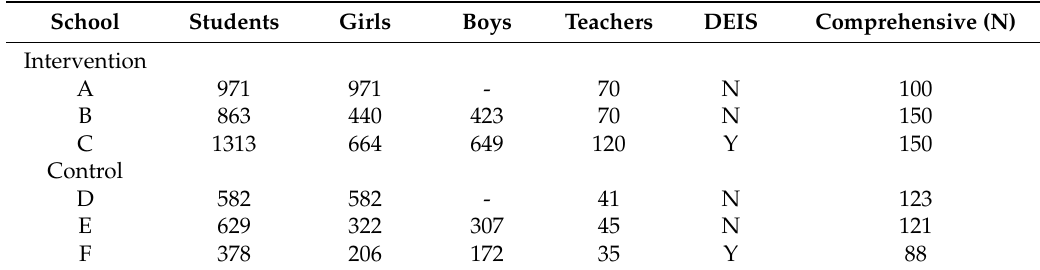
Table 4. Sample size